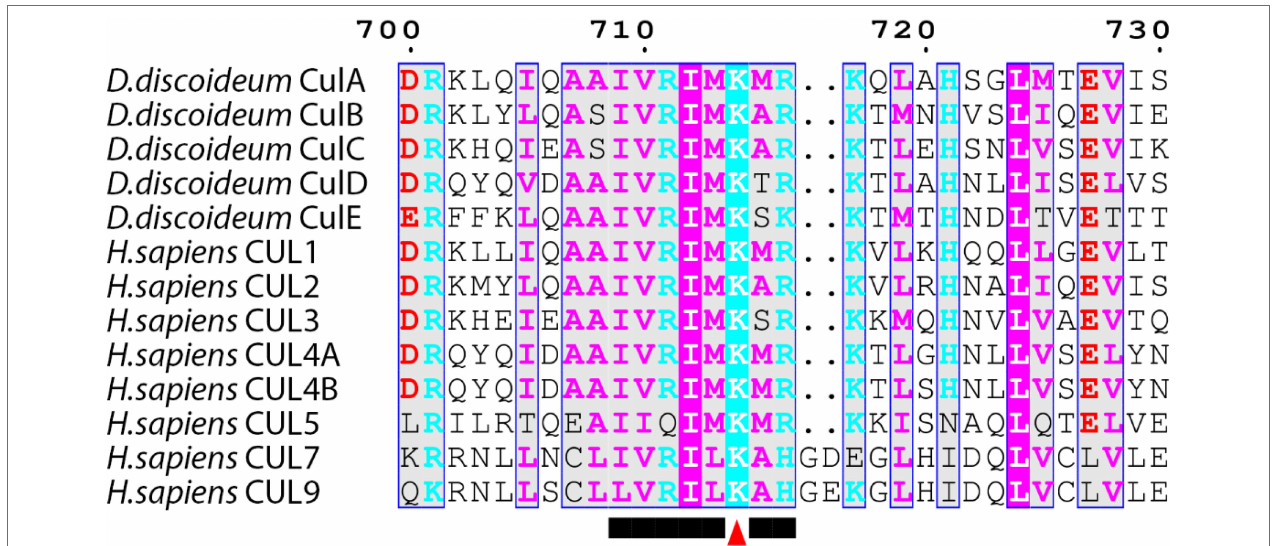
FIGURE 4 | Alignment of cullins from Dictyostelium discoideum and human. Sequences were aligned on MEGA7 using the MUSCLE alignment and displayed using ESPript 3.0. Colored residues indicate physiochemical properties and conservation at a position. Arrowhead marks the lysine motif where the NEDD8 protein is conjugated within the conserved